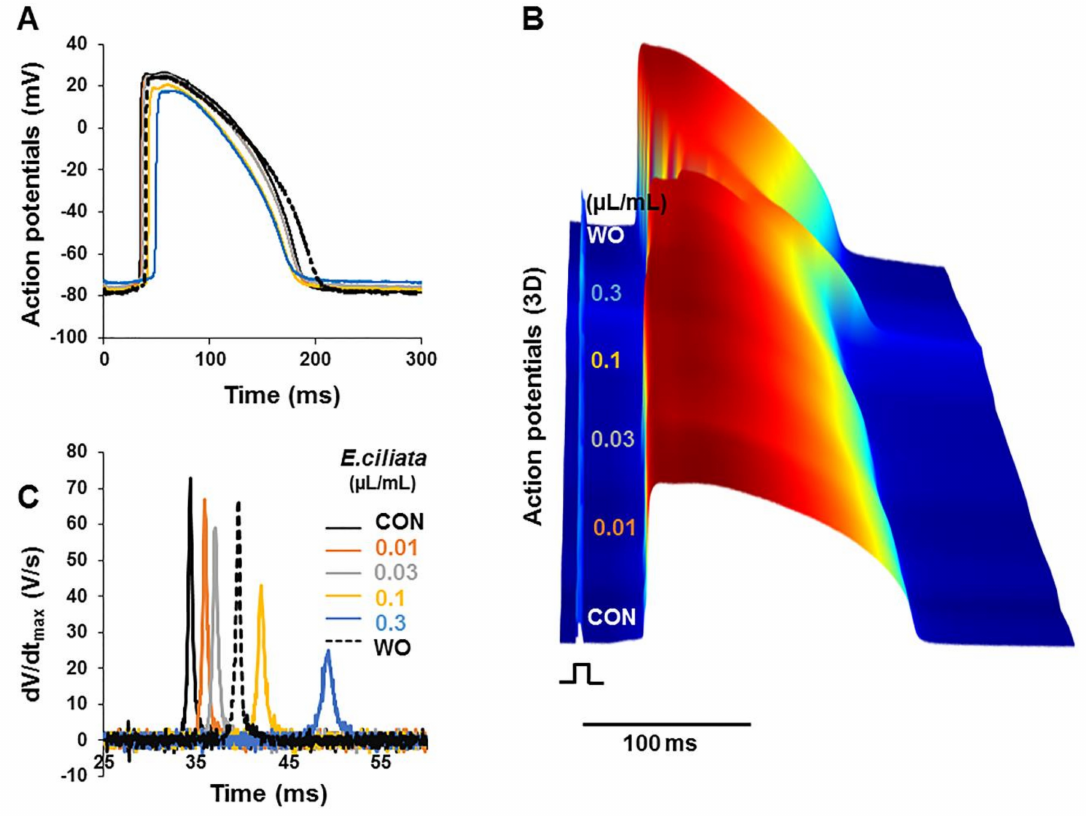
Figure 2. E. ciliata e ff ects on the action potentials (APs) of Langendor ff -perfused rabbit heart. Epicardial pacing with a 300 ms period was applied. ( A ) Superimposition of representative traces of APs from microelectrodes, from the same experiment as in Figure 1, under control conditions (CON; black) and after application of 0.01, 0.03, 0.1, and 0.3 µ L / mL concentrations of E. ciliata (orange, grey, yellow and blue, respectively), followed by washout without the E. ciliata (WO; dotted). ( B ) Three-dimensional (3D) view of APs, from front to back, showing time-dependent e ff ect of E. ciliata from the same data as in ( A ); 3D view construction details are the same as in Figure 1B. ( C ) Values of the maximal velocity of APs upstroke (dV / dt max ) after application of E. ciliata concentrations as indicated from the same experiment as in ( A